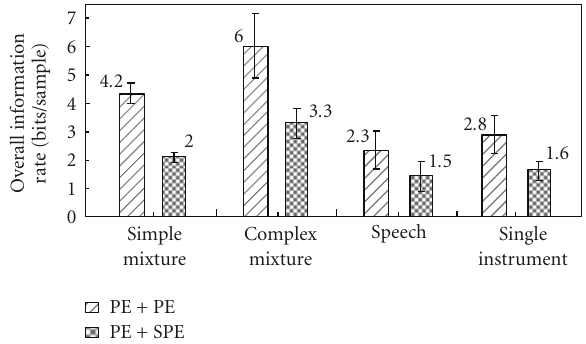
Figure 17: Perceptual Information of stereo sequences sampled at 44.1kHz, evaluated using PE and